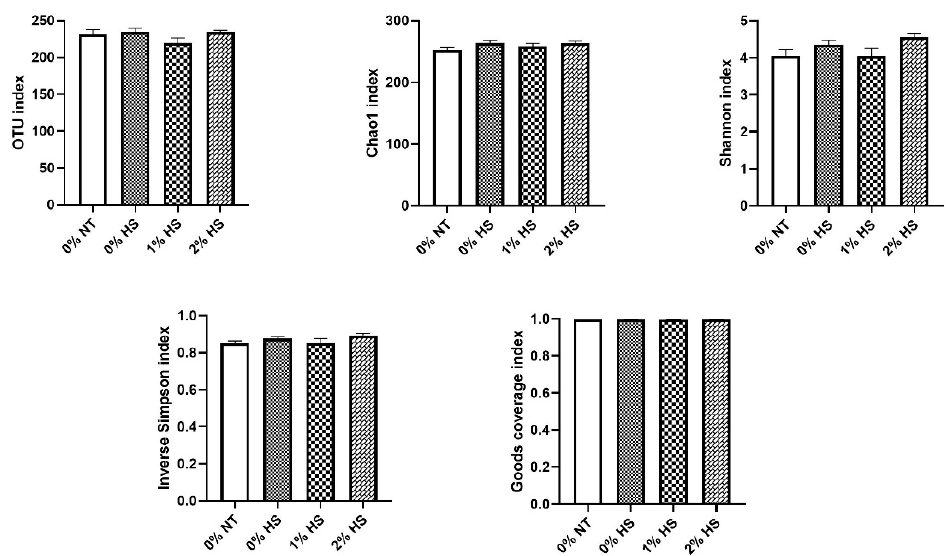
Figure 3. Effects of dietary shredded, steam-exploded pine particles (SPP) supplementation on the community richness and diversity of cecum microflora in broiler chickens exposed to either thermoneutral or heat stress conditions. The treatments were control diet containing 0% SPP at ther- moneutral temperature (0% NT), control diet with acute heat stress (0% HS), 1% SPP-supplemented diet at acute heat stress (1% HS), and 2% SPP-supplemented diet at acute heat stress (2% HS). The thermoneutral birds were maintained at 21.0 ◦ C while the temperature of the heat-stressed room was raised to 31 ◦ C within the first three hours and then maintained for another three hours that made the total HS period of six hours. The PCoA based on unweighted unifrac distances were similar, while weighted unifrac distances showed scattered plots (Figure